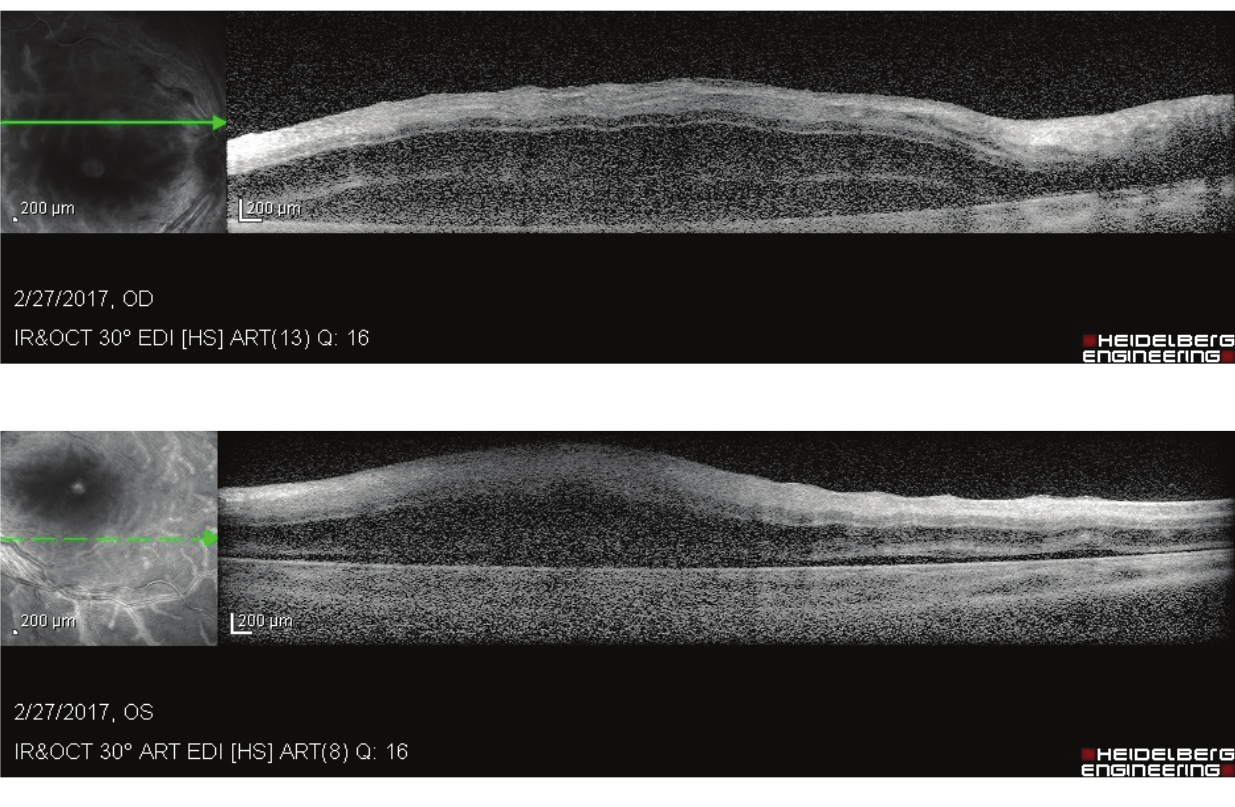
Figure 2. Spectral domain optical coherence tomography (SD- OCT) of the posterior pole reveals highly reflective retinal layers suggestive of diffuse edema and multifocal exudative retinal